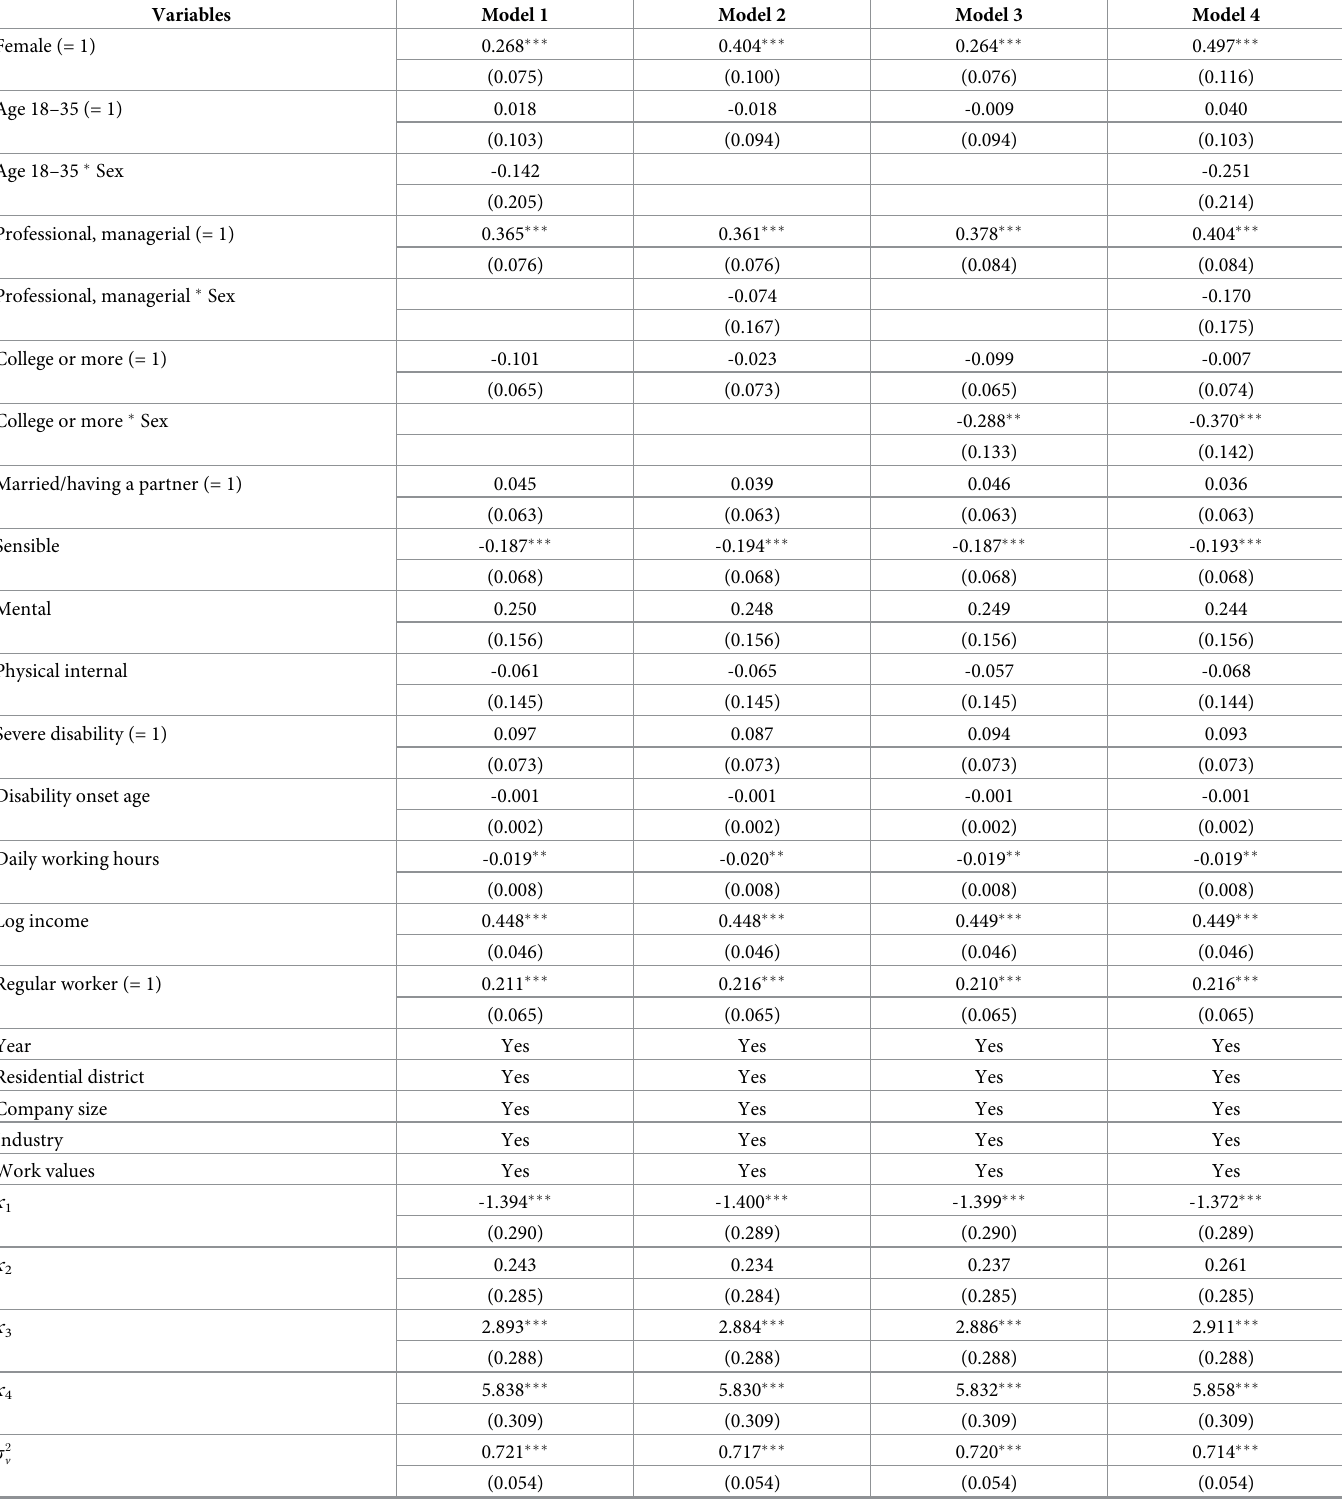
Table 5. Testing the role of